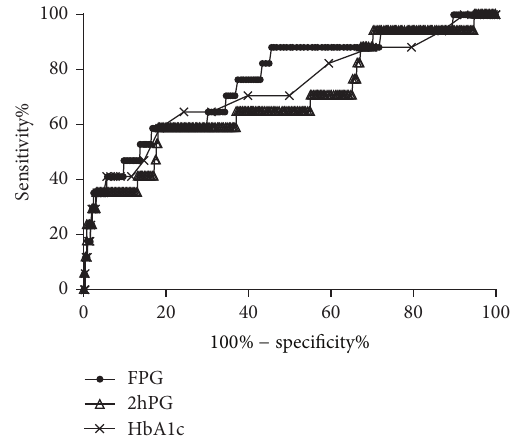
Figure 6: Receiver operating characteristic curves of glycated hemoglobin A1c (HbA1c), fasting plasma glucose (FPG), and 2-hour postload plasma glucose (2hPG) for detecting diabetic retinopathy in 2959 subjects after excluding those with known